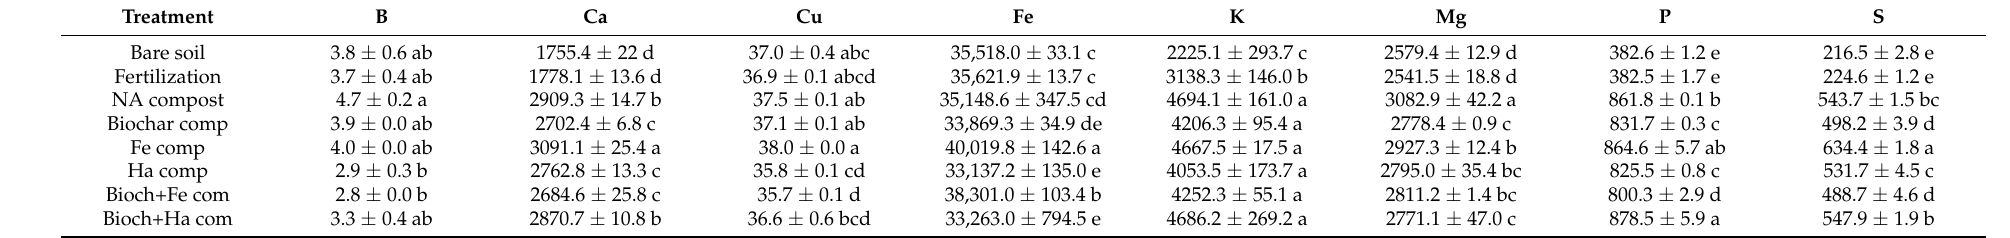
Table 2. Elemental composition of soil and compost amended soils after the greenhouse experiment according to ICP-OES spectroscopy. Treatment